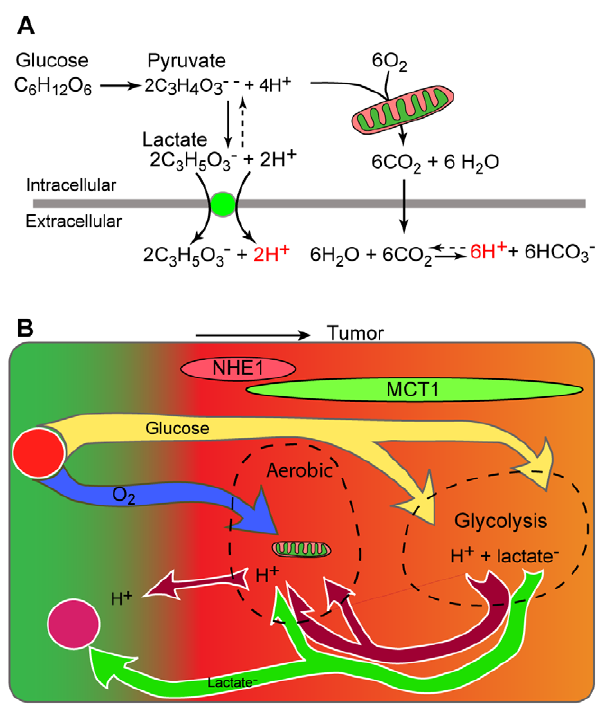
Figure 4. Roles of MCT1 and NHE1 in C6 gliomas. (A) Stoichiometry of the main pathways of glucose metabolism. Note that the protons associated with lactate production are exported by cotransport with lactate. The consequences of CO 2 production are potentially more variable than shown. (B) Scheme of fluxes of glucose, oxygen, lactate and H + in the glioma rim, suggested by the profiles of NHE1 and MCT1. Some of the lactate exported from deeper, hypoxic regions is taken up on MCT1 in the rim of the tumor and oxidized to CO 2 . Ground colors indicate pHe: red is acid, green is alkaline.